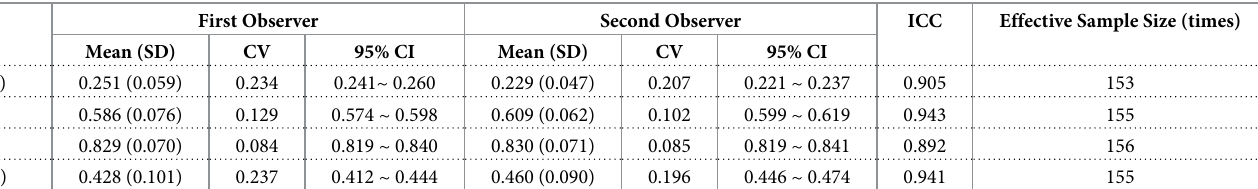
and following the rhythms of the singing. Adult women had also walked by the group, but none stopped. The interactions for cheering were only conducted among the youth them- selves, who cheered with each other by cross tapping their sticks. Many youth participants who were herders dressed in traditional style clothing, including the loosen colorful blanket clothes, sandals made from car tires, and had worn bead ornaments on their heads, necks, belts, legs, and arms. While jumping these ornaments create sounds, which enrich the rhythms of their performance. From the total of 157 double-leg jumps, the mean time set for these DLJ has the least varia- tion in contrast to other variables (Table 2). In comparison, the BCOM heights of identified DLJ show greater variations. This means, all the jumpers retained normal velocity during the DLJ repetitions, notwithstanding the height reached. Among the individual jumpers, the BCOM heights of their DLJ have significant differences, ranging from 0.229m to 0.608m. Moreover, the youths, whose DLJ comprised higher mean BCOM heights, tended to perform more jumping sessions during the adumu (Fig 2). To further convert the DLJ time set into jump frequency, the derived mean ( ± SD) is 1.228 ( ± 0.298) Hz. This frequency is likely to cor- respond to the main tempo (2.28–2.32 Hz), but more detailed investigations are still needed. Table 2. Time and height features of coded DLJ. (n =